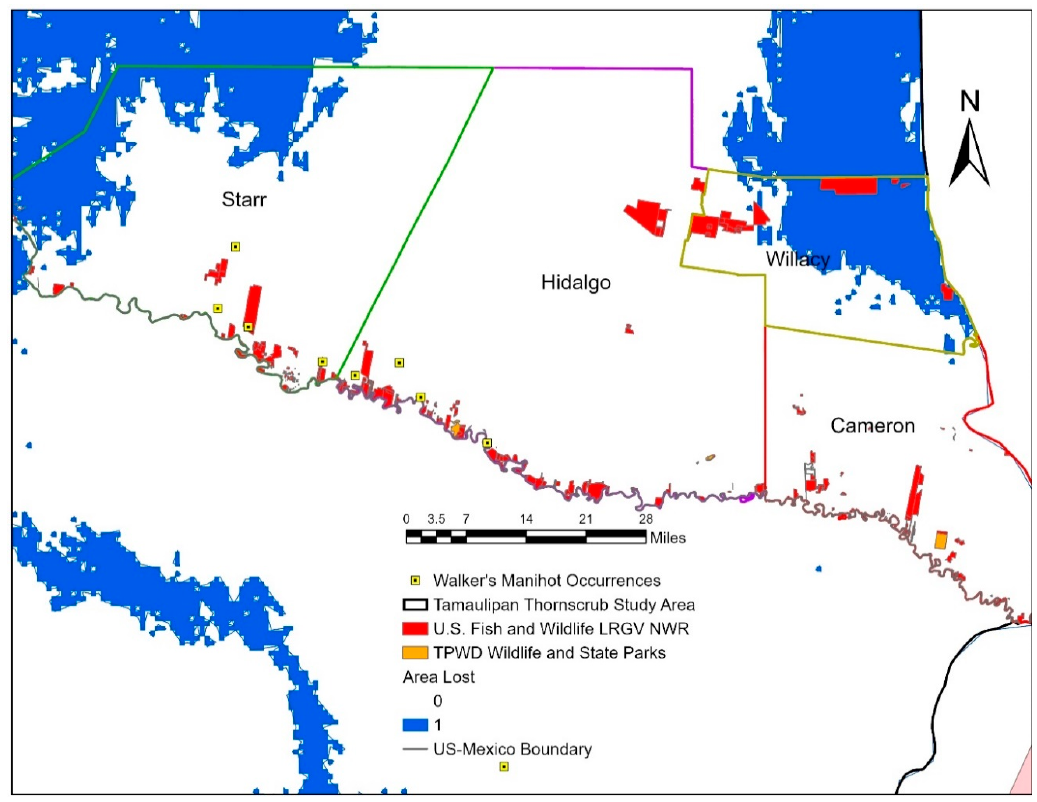
Figure 6. Detail of the suitable area lost (blue) in Lower Rio Grande Valley Texas counties of Starr, Hidalgo, Cameron, and Willacy. The protected areas that are shown to be most affected by climate change are U.S. Fish and Wildlife Service LRGV NWR tracts located in Willacy County.